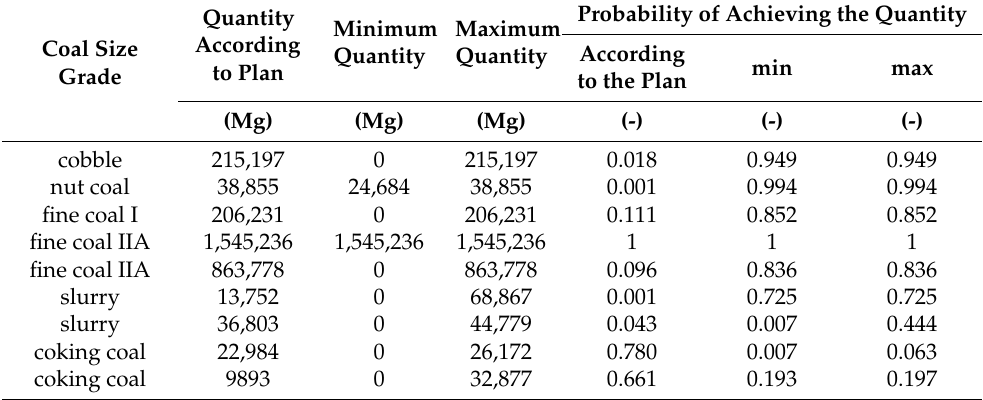
Table A14. A summary of the volumes of sales of the individual coal grades with the probability of their achievement at σ yprog for mine “E”.